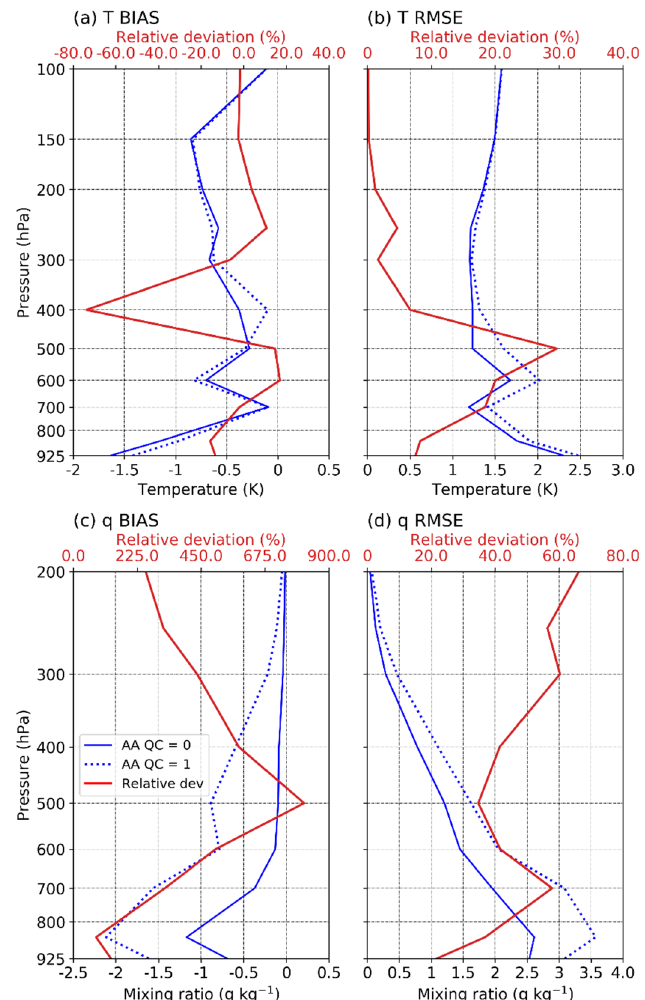
Figure 9. Mean bias (left column) and RMSE (right column) of AIRS / AMSU (AA) data against RAOB for different QC level (QC = 0 solid blue lines and QC = 1 dashed lines). The relative deviations of bias and RMSE between QC = 0 and QC = 1 are shown in red lines. ( a ) shows bias of T, ( b ) RMSE of T, ( c ) bias of q, and ( d ) RMSE of q.